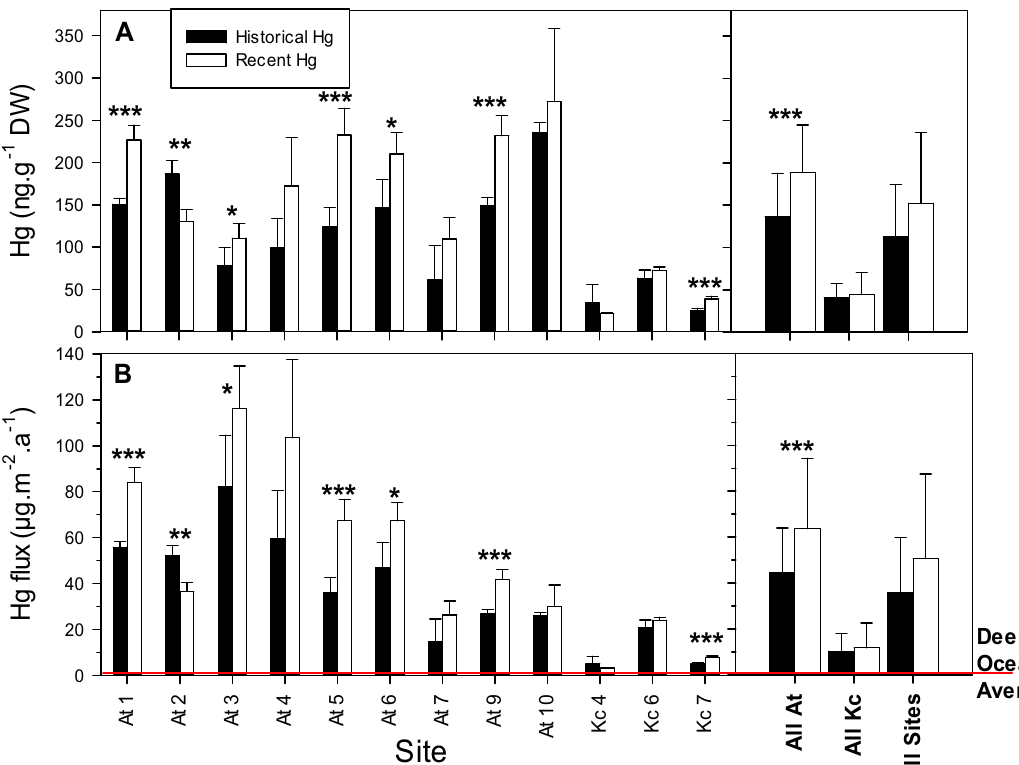
Figure 2. Plots of average ( A ) Hg concentrations and ( B ) Hg fluxes at the deep-ocean study sites. Left hand panels show concentration and fluxes for recent and historical sediments at individual sites. Right hand panels show concentrations and fluxes at all At and all Kc sites combined, and the concentrations and fluxes in recent and historical sediments of all sites. For individual sites, in ( A ) bars represent mean ± standard deviation (SD) Hg concentrations in the upper 5 cm (“recent”, N = 5) and bottom 5 slices (“historical”, N = 5) of sediment cores. In ( B ), bars represent mean ± SD Hg fluxes calculated from the mean and SD concentrations and sediment accumulation rates. Significant differences between recent and historical Hg concentrations and fluxes indicated by: *P < 0.05, **P < 0.01, ***P < 0.001. The Deep-Ocean Average line represents the inferred average flux over the entire deep-ocean based on Outridge et al . 1 and Zhang et al . 3